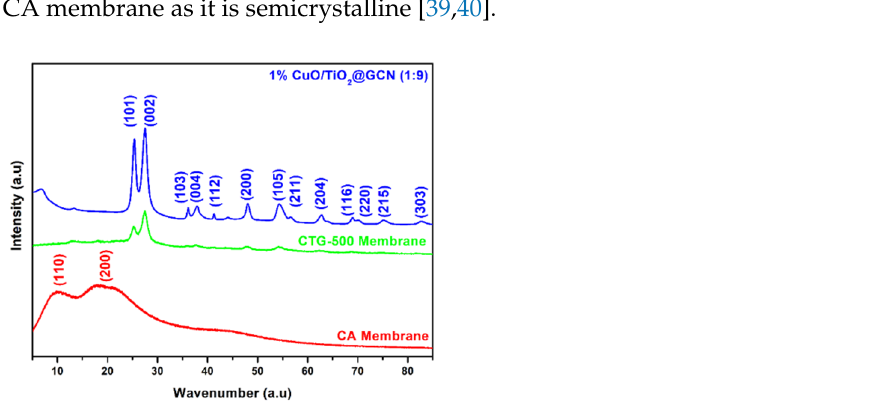
Figure 1. XRD patterns of 1% CuO/TiO 2 @GCN (1:9) powder and 1% CuO/TiO 2 @GCN (1:9)-CA (CTG–500) membrane and cellulose acetate (CA) membrane.